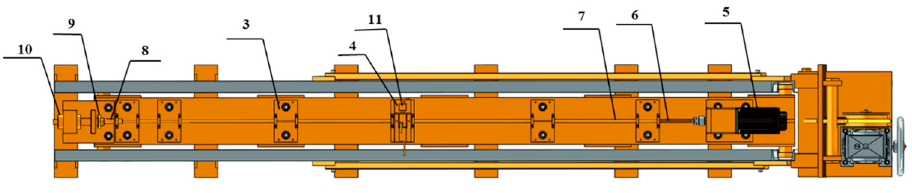
Figure 5. Top view of the experimental setup.